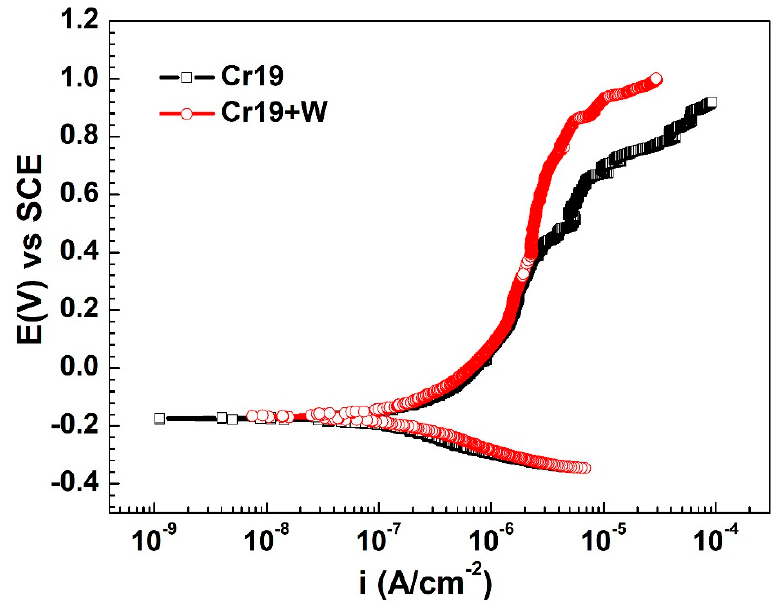
Figure 1. Polarization curves of Cr19 and Cr19 + W DSSs in 1 mol/L NaCl at 25 °C. Lijun Yang et al. [29] studied the microstructure and mechanical properties of 316L alloy samples formed by selective laser melting (SLM) after different heat